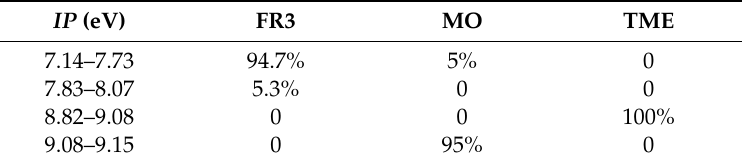
Figure 8. Reaction between the trimethylolpropane and saturated fatty acids [25]. Table 1. The distribution of the IP of the three insulation oils.